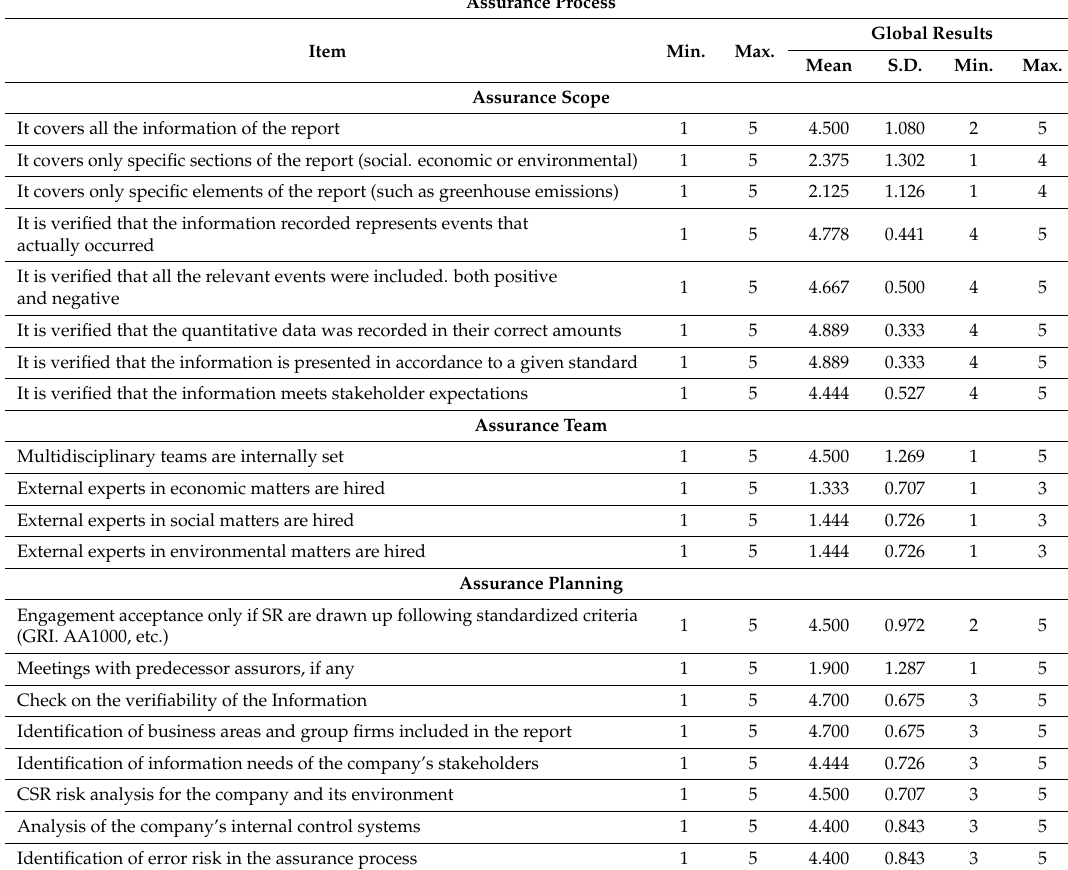
Table 5. Assurance process: general